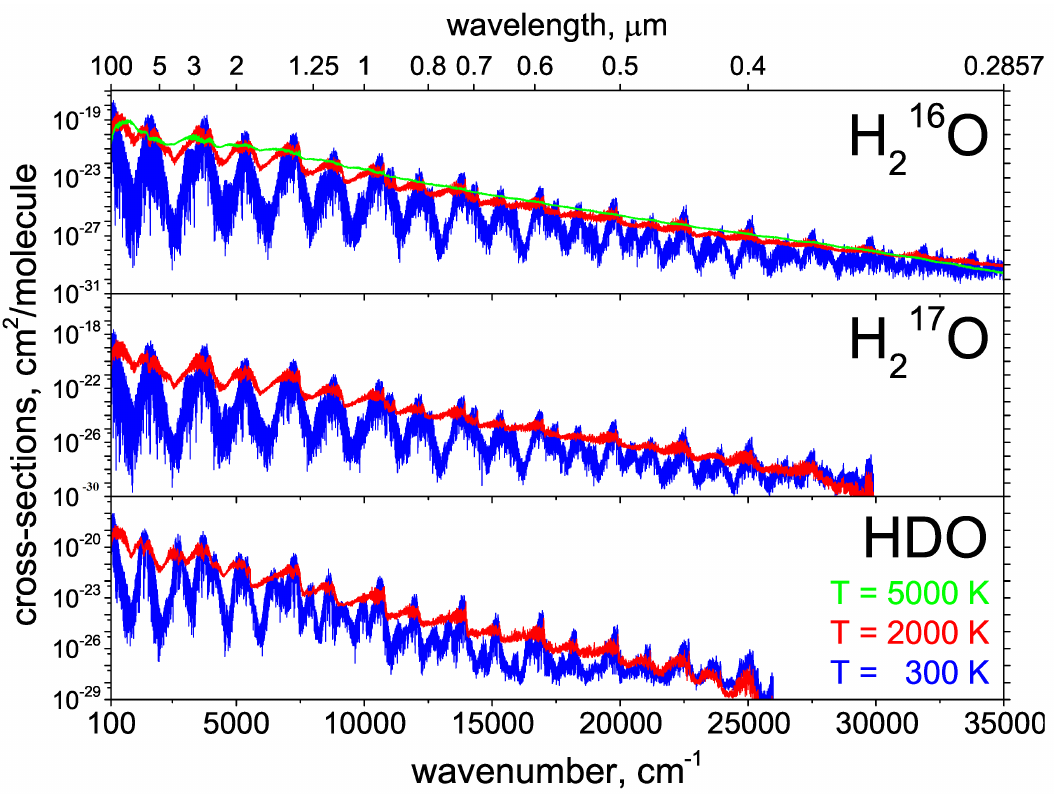
Figure 1. Cross sections for H 2 16 O from the POKAZATEL line list [5], H 2 17 O from the HotWat78 line list [68] and HDO from the VTT line list [93]. All cross sections are for 100%